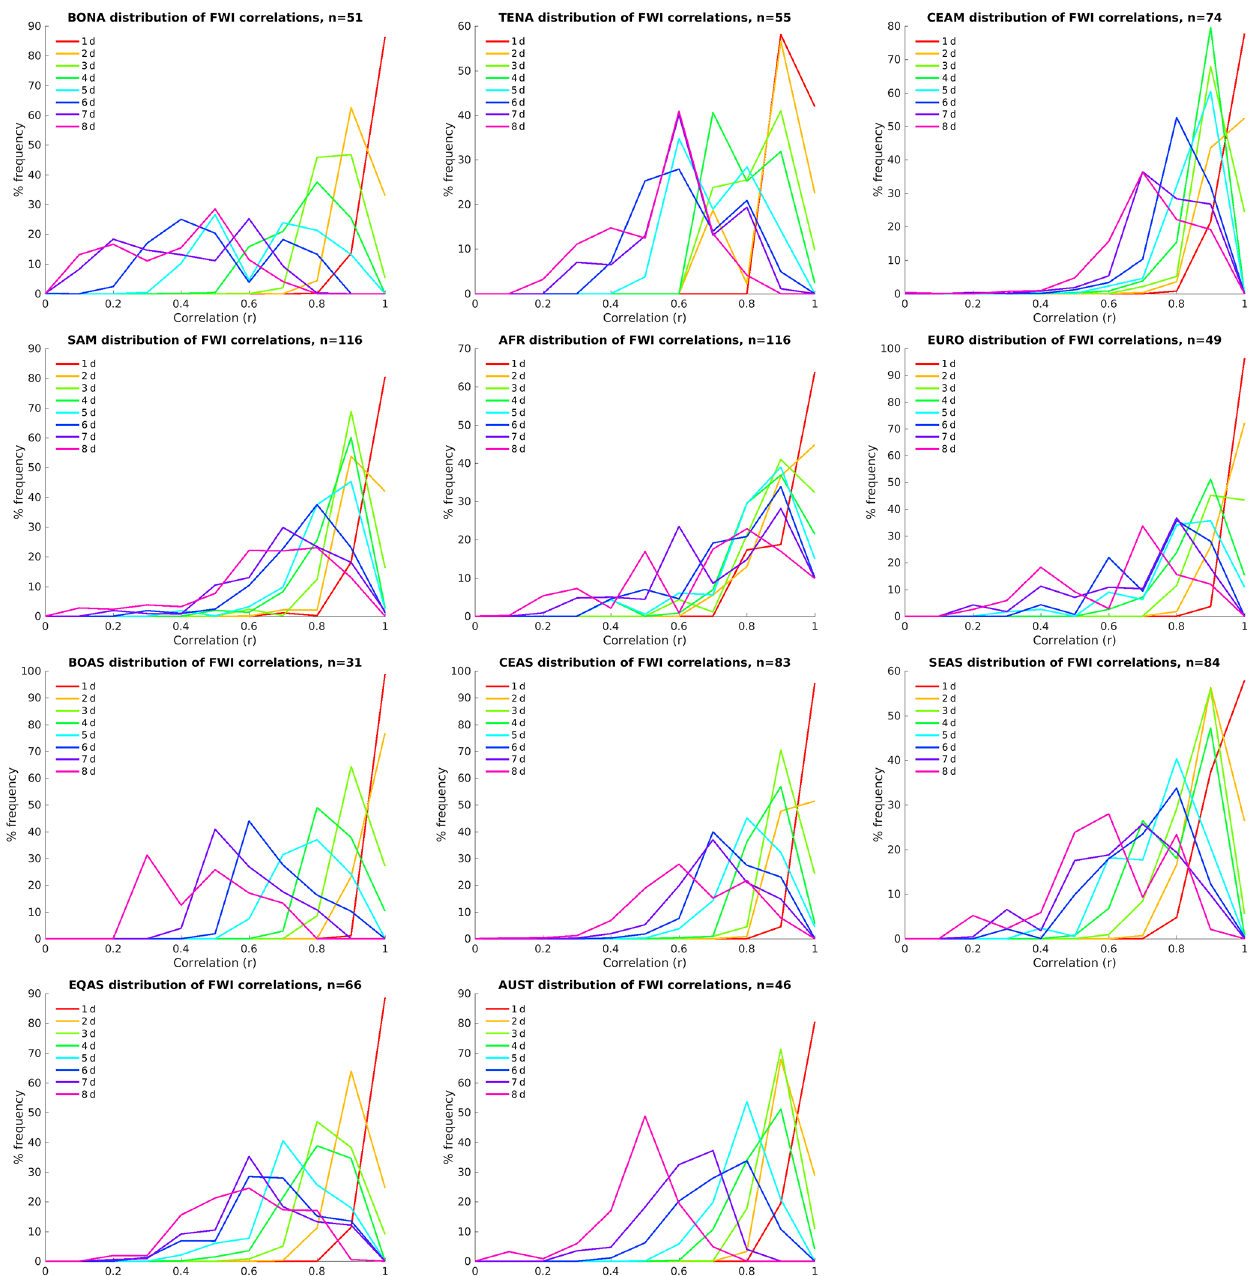
Figure 12. Distributions of correlations between daily GEOS-5 forecast and analysis FWI at different lead times for ecoregions in each GFED